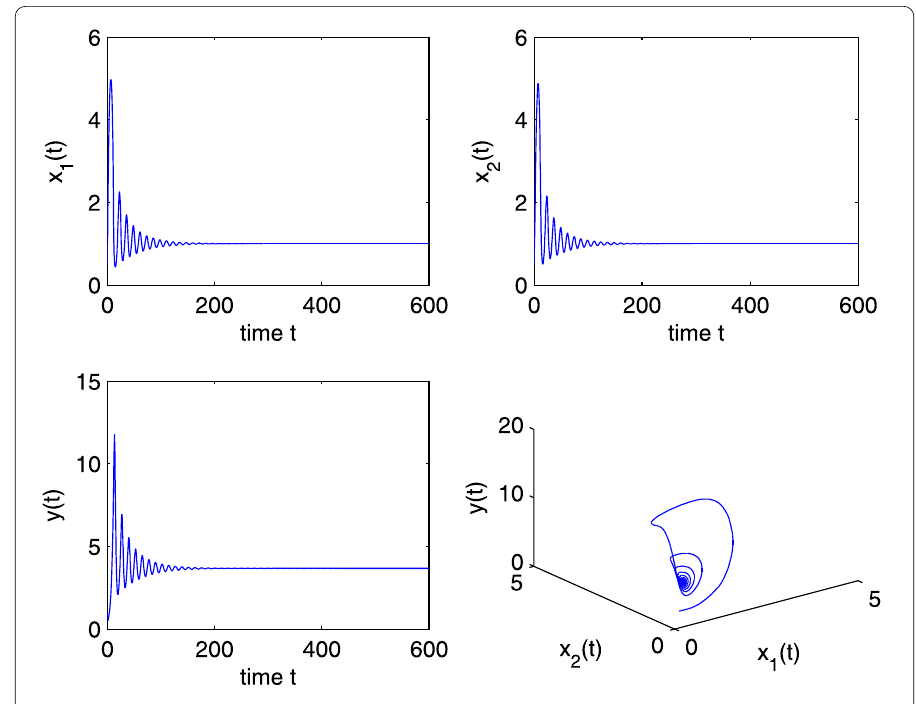
Figure 1 When τ 1 = 0, E ∗ is asymptotically stable for τ 2 = 1.46 < τ 20 =